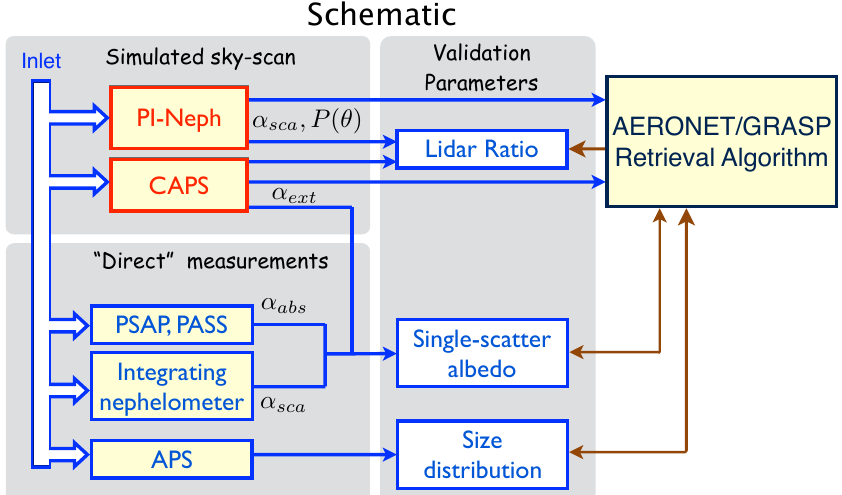
Figure 1. Apparatus for comparing aerosol remote sensing retrievals to in situ measurements. The Polarized Imaging Nephelometer (PI-Neph) and Cavity Attenuated Phase Shift monitor (CAPS) provide angular scattering and extinction measurements required for the Generalized Retrieval of Aerosol and Surface Properties (GRASP) retrieval algorithm. The GRASP algorithm reports the LiDAR ratio, single-scatter albedo, and the aerosol size distribution; results are verified with “direct” in situ measurements shown in the lower left corner, including the Particle Soot Absorption Photometer (PSAP), the Photo-Acoustic Soot Spectrometer (PASS), an integrating nephelometer, and Aerodynamic Particle Sizer